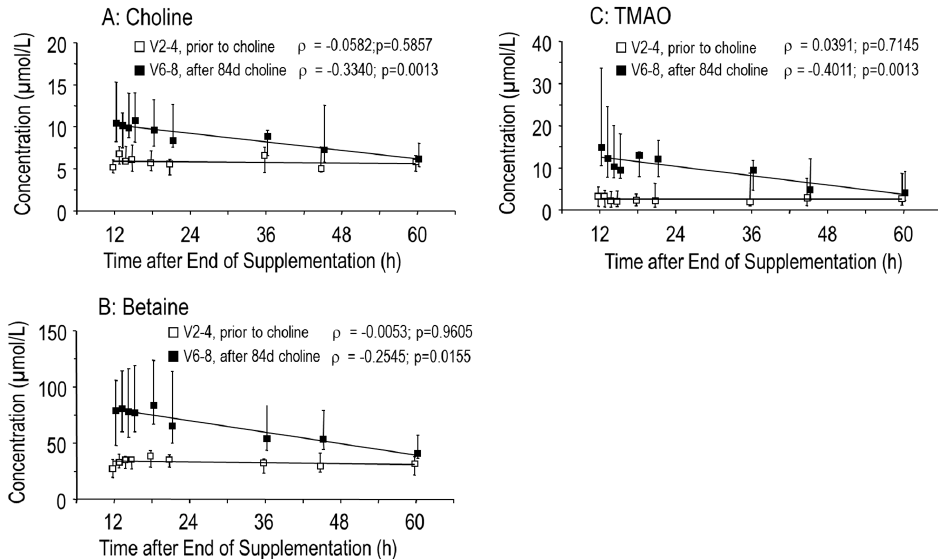
Figure 2. Plasma concentrations of choline ( A ) and its metabolites betaine ( B ) and trimethylamine oxide (TMAO) ( C ). Data are values of 10 adult male CF patients over 48 h prior to choline supplementation (visit 2–4 [V2–4], white symbols) and from 12 h after the end of choline supplementation (84 (84–91) days) onwards (V6–8, filled symbols). Abbreviations: ρ , Spearman rank correlation coefficient; p , significance level.